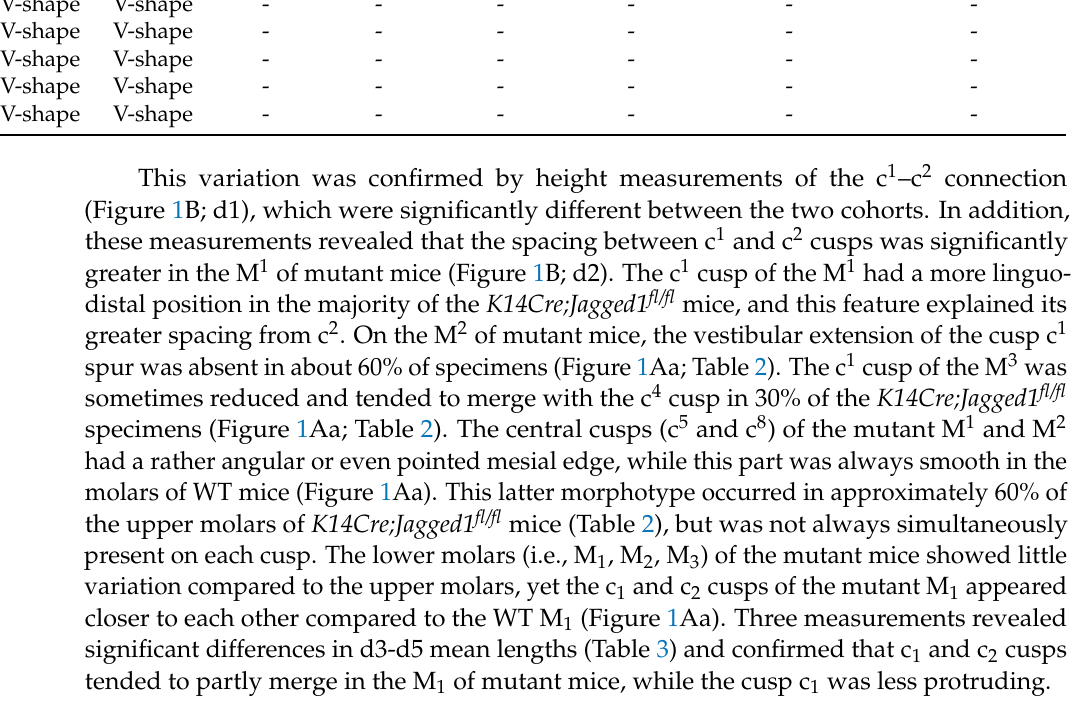
Table 3. Morphological variations in the lower molars of K14Cre;Jagged1 fl/fl mice. Differences in d3-d5 mean lengths indicating that the c1 and c2 cusps are partly merged in the first lower molars (M 1 ) of K14Cre;Jagged1 fl/fl